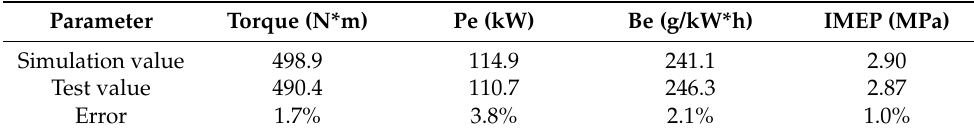
Table 6. Comparison of simulation and test performance indicators of checkpoints.